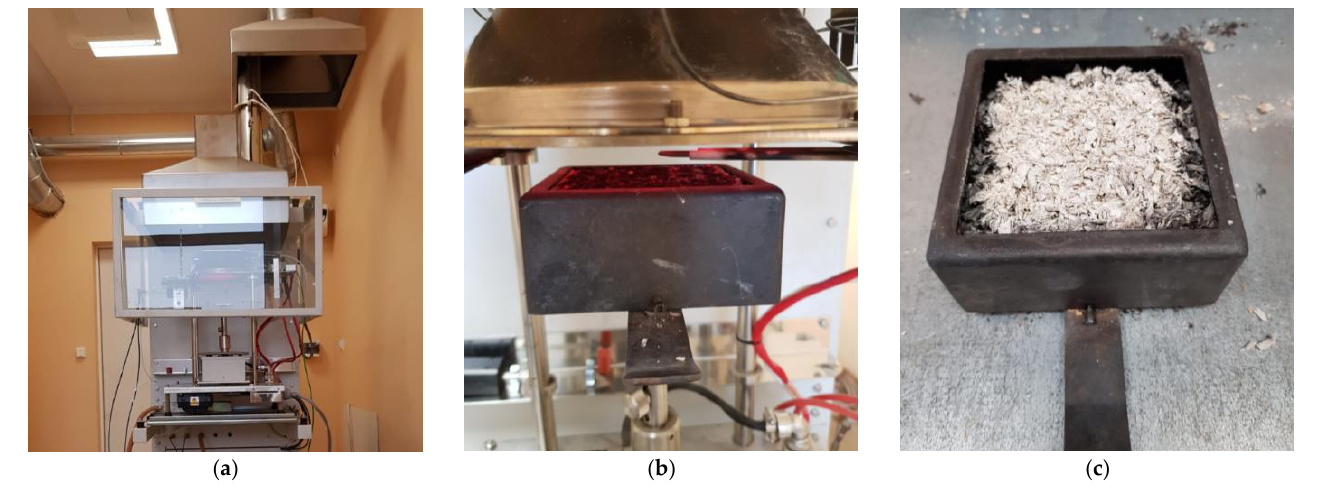
Figure 1. Experimental setup of cone calorimeter test method according to ISO 5660-1: ( a ) cone calorimeter; ( b ) test procedure; ( c ) tested sample.